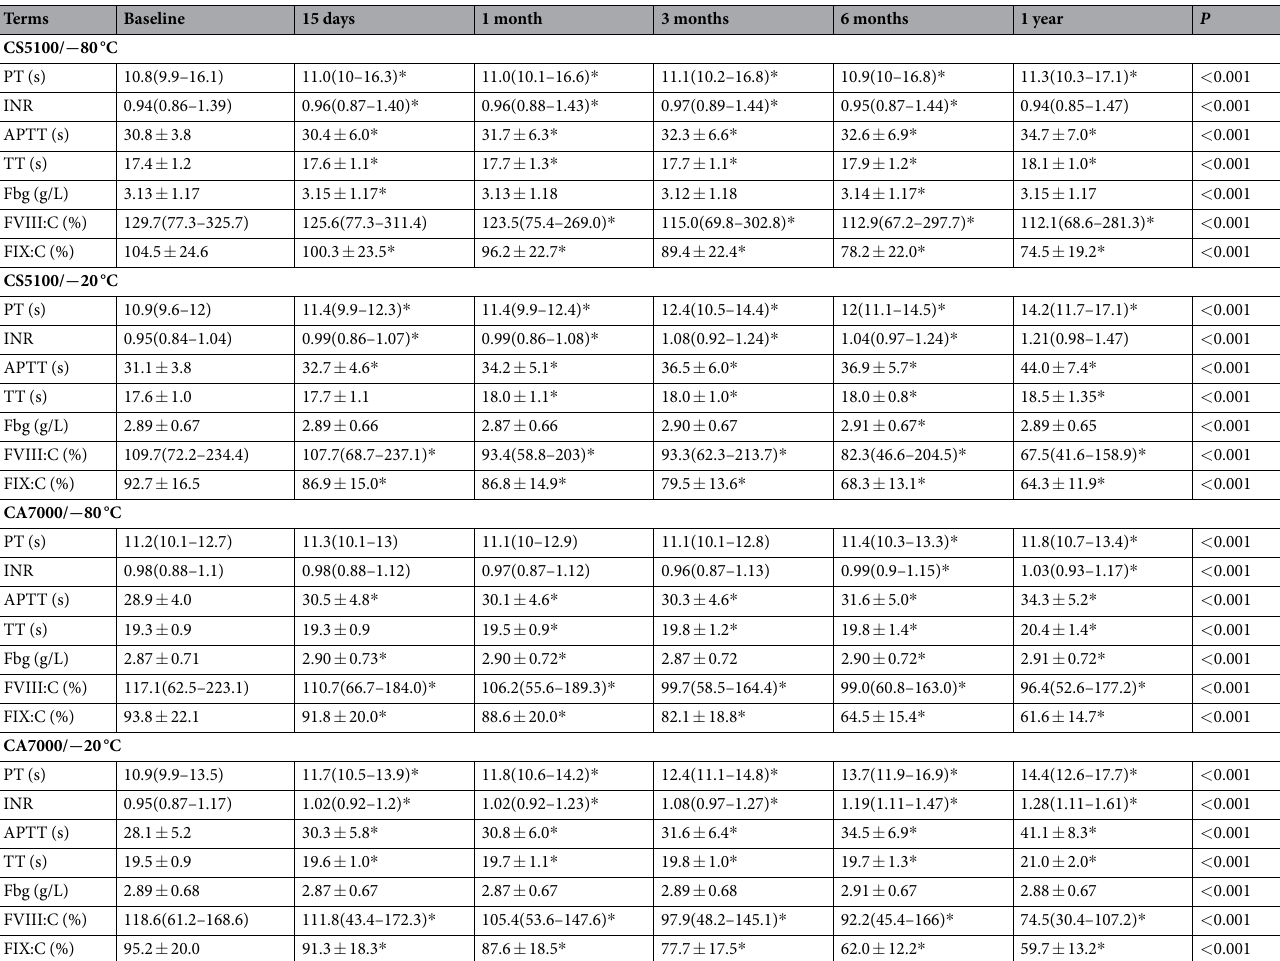
Table 1. Results for PT/INR, APTT, Fbg, TT, FVIII:C, and FIX:C detected by the CS5100 and CA7000